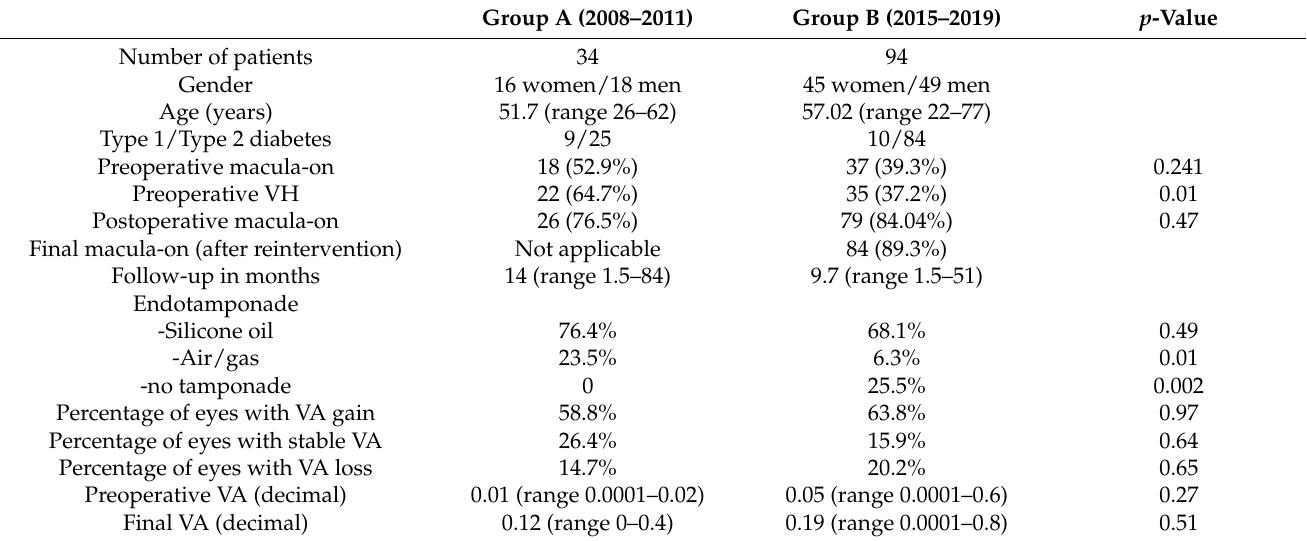
Table 1. Comparison between group A (patients operated between 2008 and 2011) and group B (patients operated between 2015 and